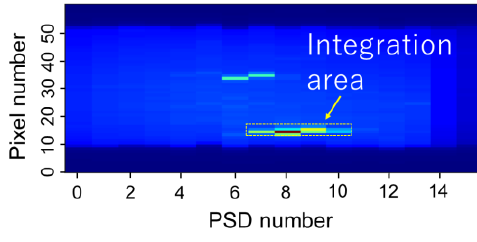
Figure 9. Detector image at 0